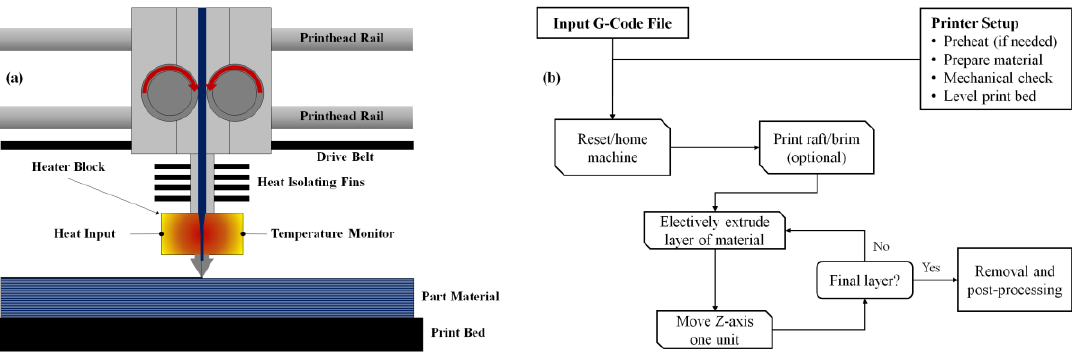
Figure 1. FDM ( a ) basic process mechanics; ( b ) the basic process algorithm.